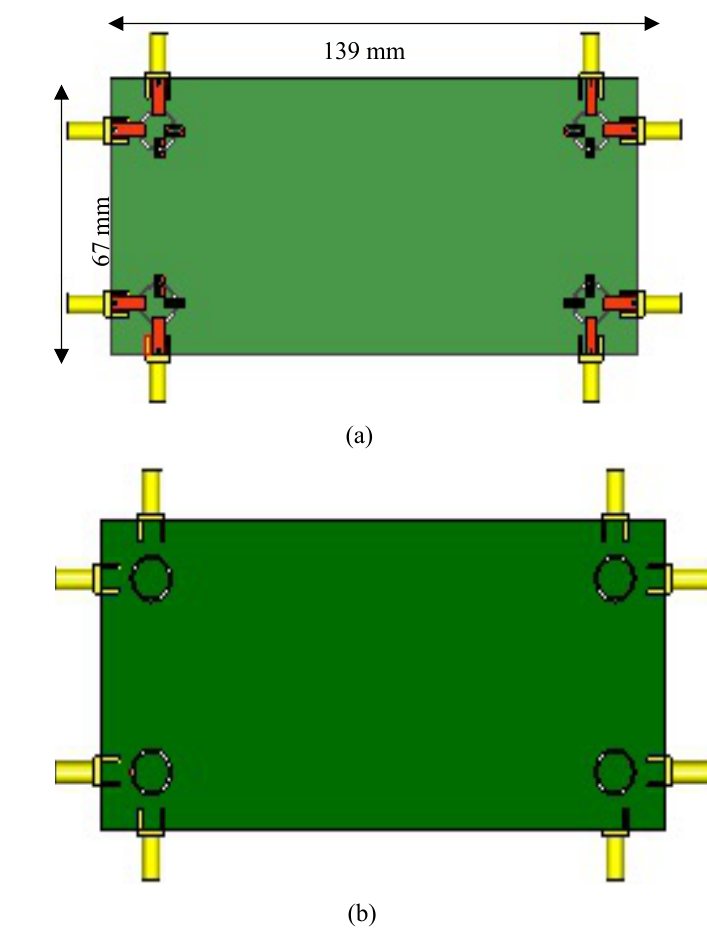
FIGURE 2: MIMIO antenna system (a) top view and (b) bottom